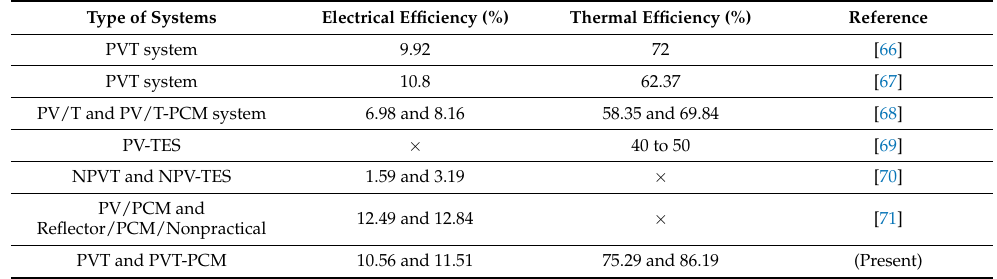
Table 5. Comparative performance assessment of the present with the previous study. Re-